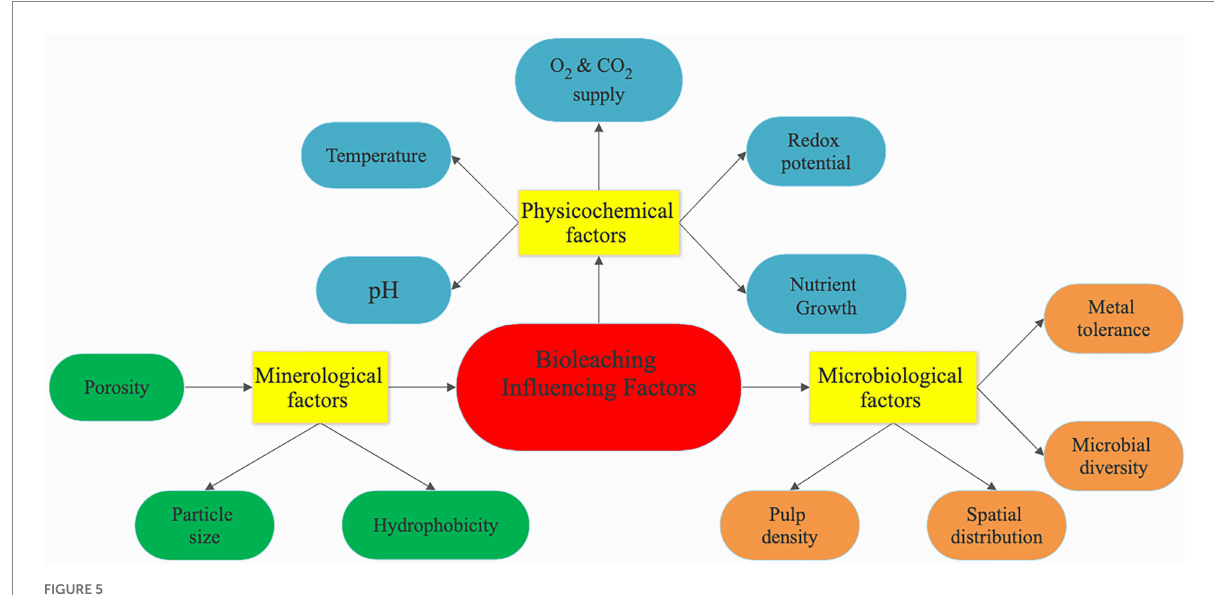
FIGURE 5 Influencing factors affecting the bioleaching